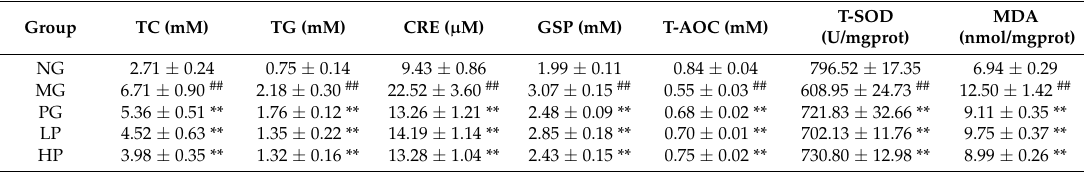
Table 2. Regulation effects of polysaccharides on biochemical